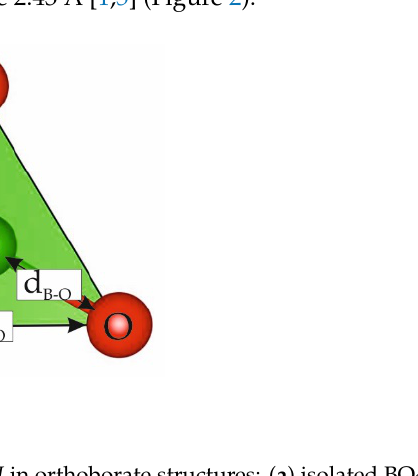
Figure 2. FSU in orthoborate structures: ( a ) isolated BO 3 –triangles and ( b ) BO 4 –tetrahedra.